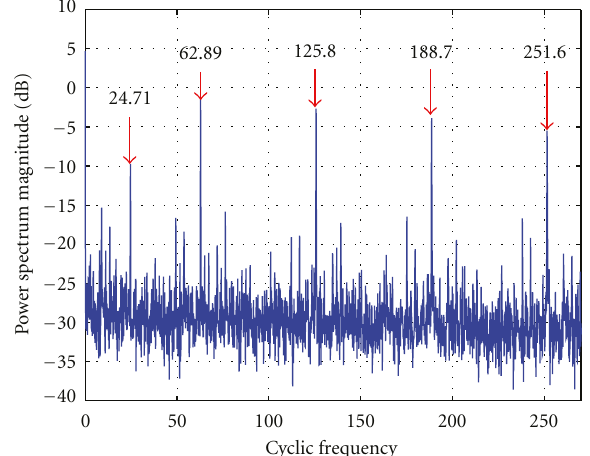
Figure 8: Power spectrum density of squared envelope of vibratory signal.